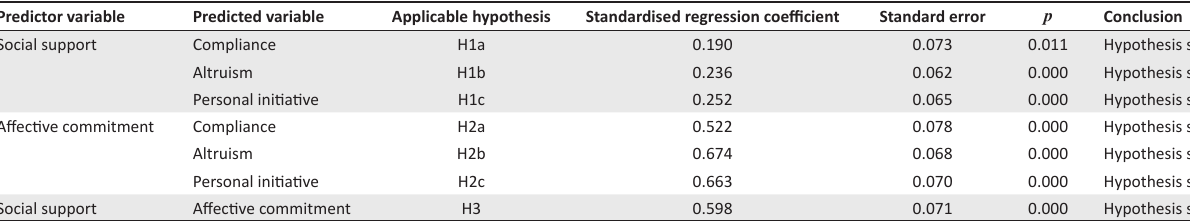
TABLE 2: Hypothesis test results.